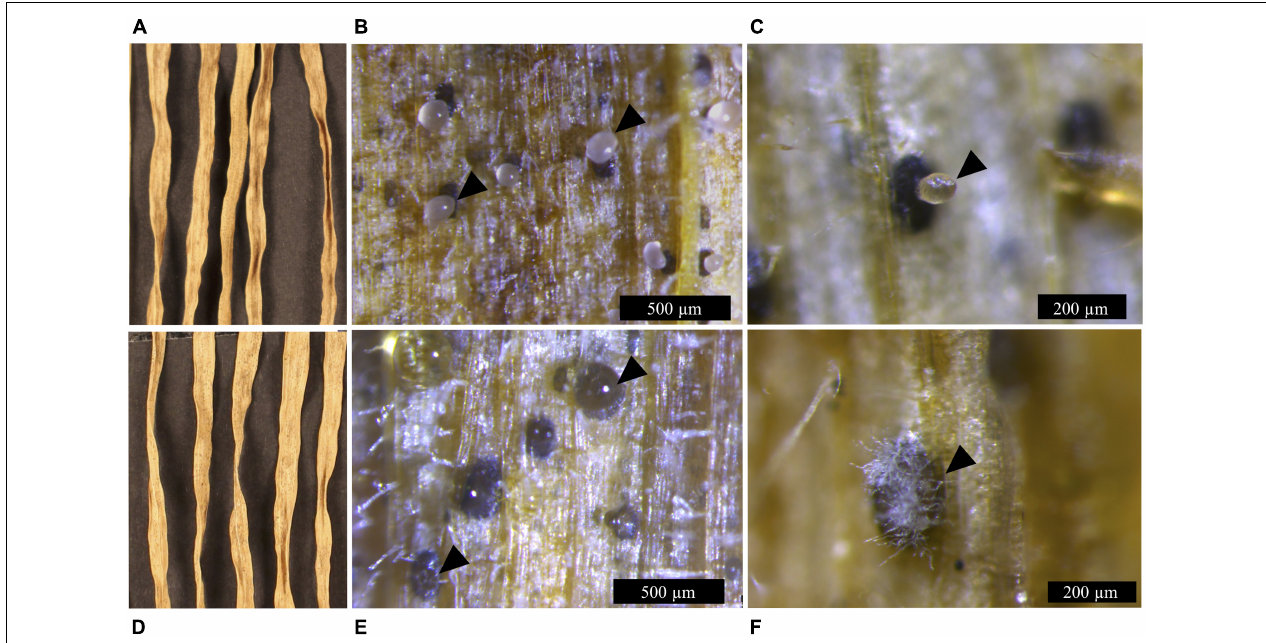
FIGURE 5 | Infection symptoms of wheat leaves (cv. Riband) infected with the Z. tritici IPO323 strain and the (cid:49) ztvelB mutants at 28 dpi. Images representative of three independent (cid:49) ztvelB mutants tested against IPO323. Experiments were carried out in triplicate with 7–12 technical repeats each time. Leaves were inoculated with a plug extracted from a 10-day-old CDV8 agar plate dipped in 0.1% Tween 20. Samples were collected at 28 dpi and incubated under high humidity to induce cirrhus release. (A) IPO323 produces necrotic lesions after 28 dpi. (B,C) dark brown pycnidia on the infected wheat leaves which produce hyaline cirrhus from the ostiole (indicated by arrowheads). (D) the (cid:49) ztvelB mutants produce necrotic lesions on wheat leaves. (E,F) pycnidia are dark brown in colour with clear cirrhus and some have white aerial hyphae on the exterior, developing from the ostiole region (indicated by arrowheads).